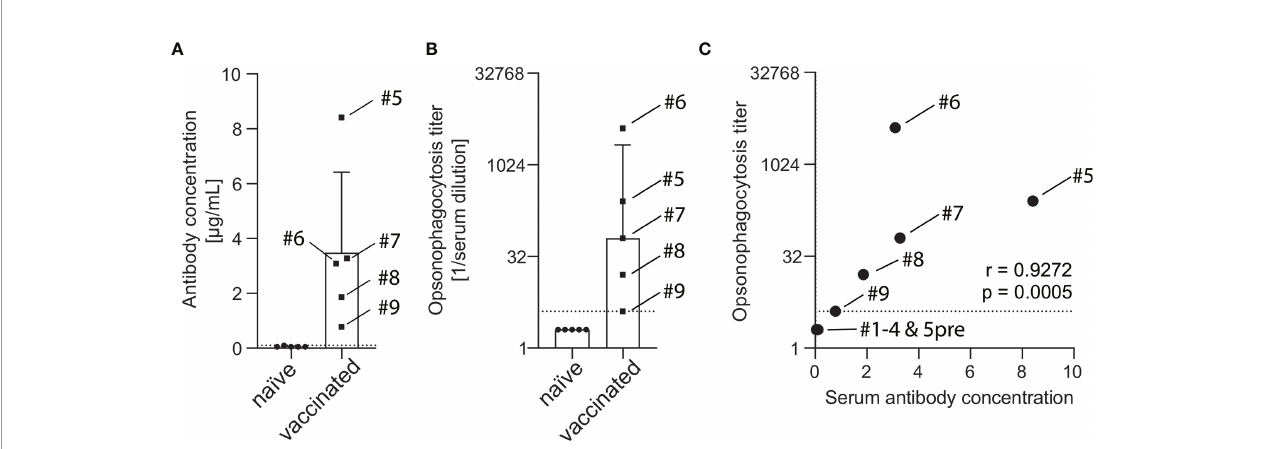
FIGURE 2 | Concentration of capsule polysaccharide-speci fi c IgG and opsonophagocytic titers in sera of vaccine-naïve and PCV13-vaccinated subjects. A pneumococcal IgG Bioplex assay was used to measure antibody concentrations in the serum of fi ve vaccine-naïve and fi ve PCV13-vaccinated subjects. Vaccinated study participants had statistically signi fi cant higher antibody concentrations than the vaccine-naive group (3.48 ± 2.93 µg/mL vs. 0.06 ± 0.02 µg/mL, p = 0.031). The box indicates the sample mean and the standard deviation and the dotted line represent the lower limit of quanti fi cation (A) . Pneumococcal opsonophagocytic titer were determined using PBS-washed EDTA-anticoagulated blood cells reconstituted with diluted heat-inactivated serum and 20% active baby rabbit complement. Vaccinated study participants had statistically signi fi cant higher titers than the vaccine-naïve group (median titer 64 vs. 2, p = 0.0079). Boxes indicate sample median and interquartile range and the dotted line represents the lowest quanti fi able opsonophagocytic titer (B) . IgG levels and opsonophagocytic titers revealed a strong positive correlation (C) . Serum from subject #5 before vaccination was available for these